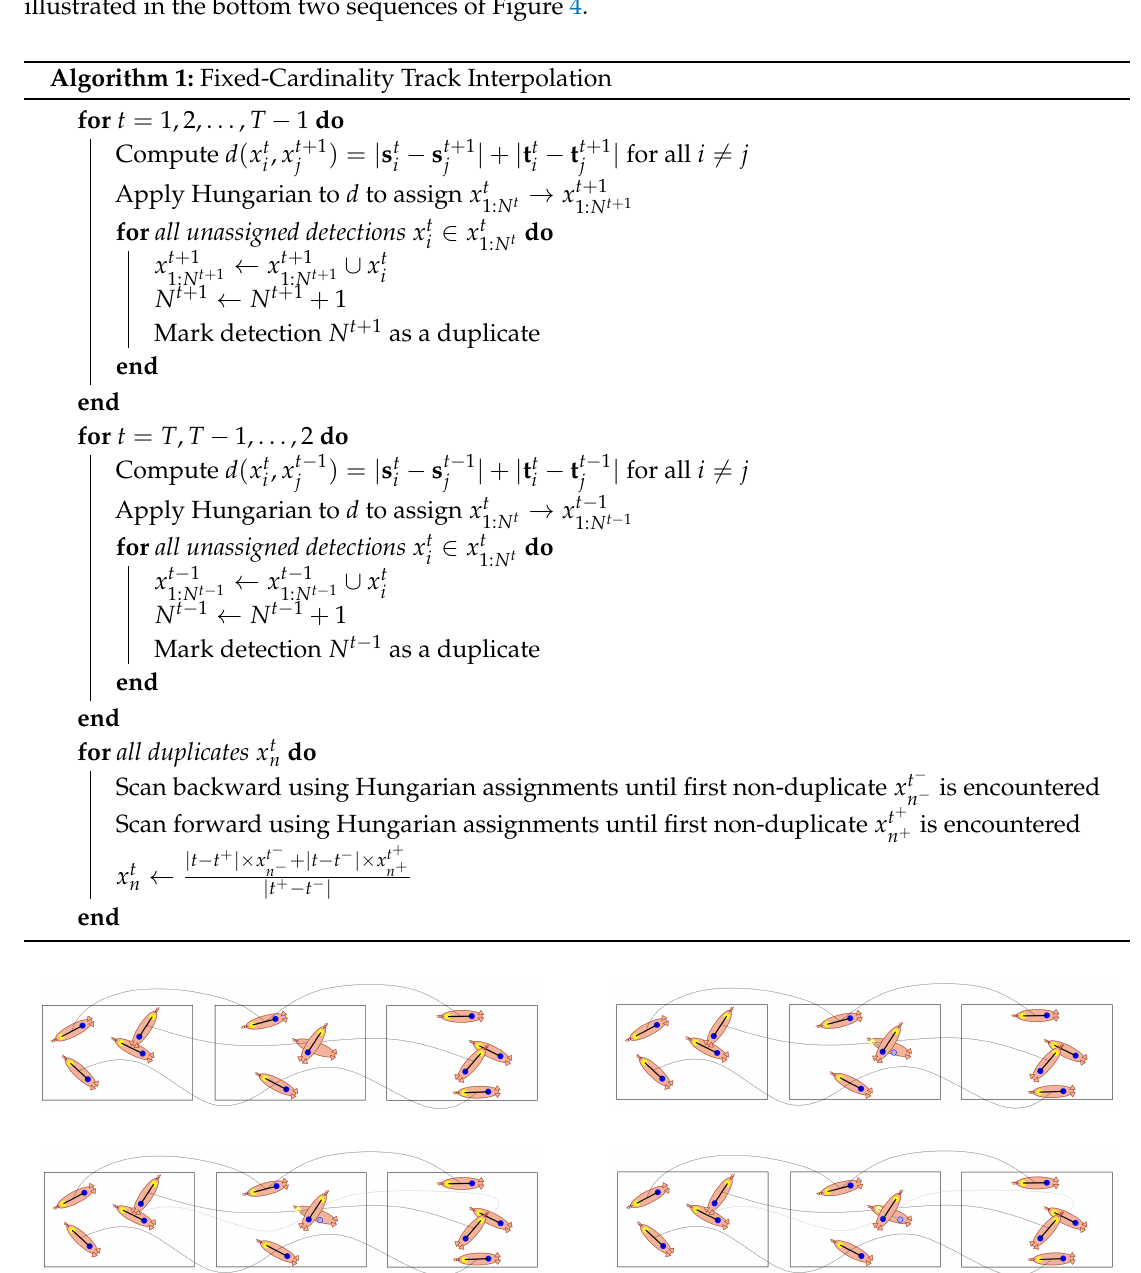
Figure 4. The figures illustrate a situation with four pigs in three consecutive frames. In the first stage (top-left), three of the four pigs are tracked and one is missed in the middle frame due to partial occlusion. As a result that there is an unassigned pig from the previous frame, that pig’s location is duplicated and marked as a duplicate (top-right). With a consistent number targets per frame, the Hungarian algorithms is used to join targets between frames (bottom-left). Finally, the locations of the duplicates are interpolated smoothly between detections